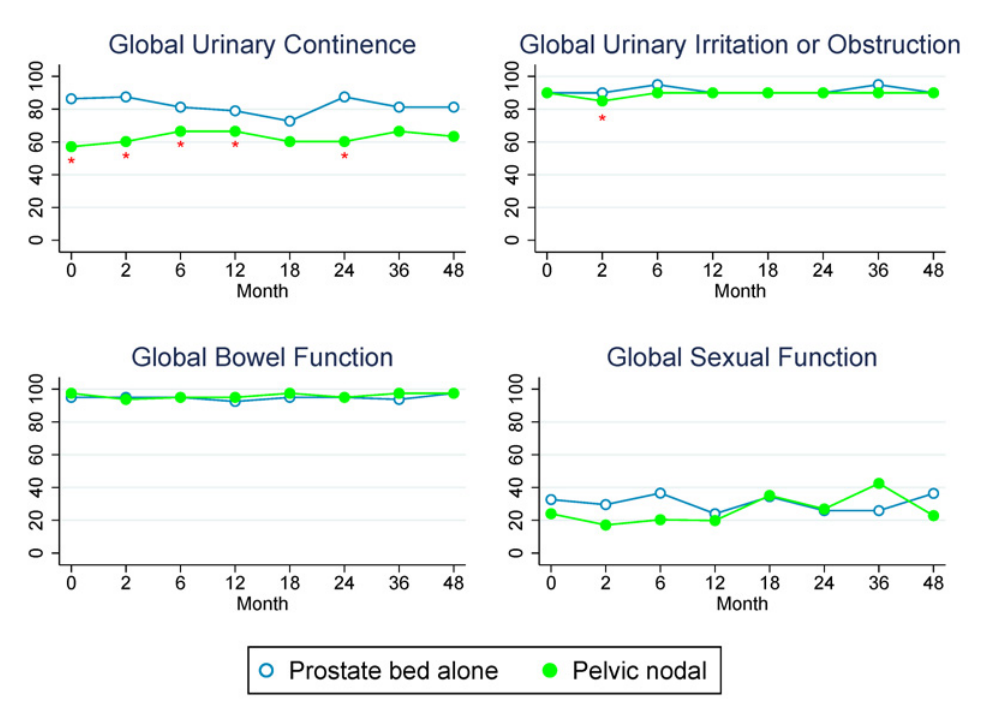
Fig 2. Changes in median QOL scores over time for patients treated with prostate bed versus pelvic nodal RT. Asterisks designate time points at which scores were significantly different between groups ( P < 0.05 by Mann-Whitney test). Standard error bars represent interquartile range.